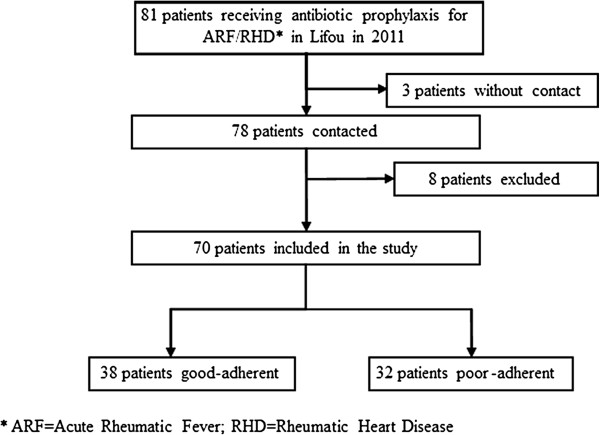
Flow chart of the enrollment of subjects, Lifou, New Caledonia, 2011.